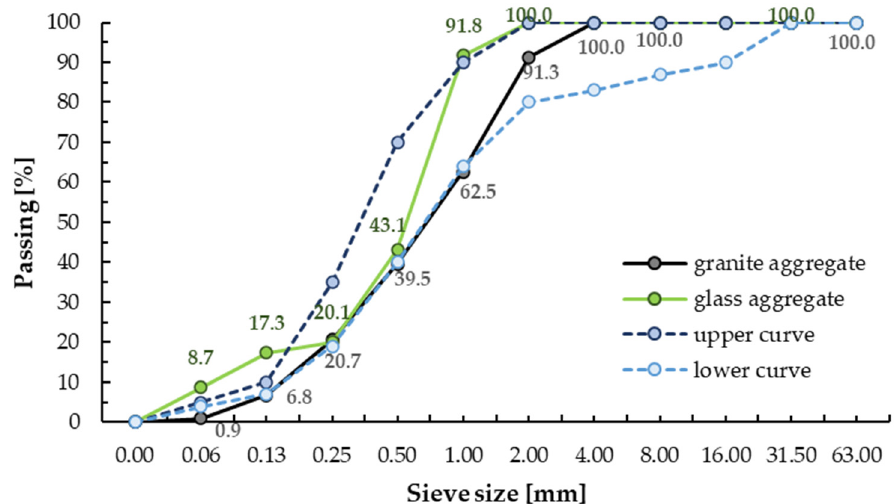
Figure 1. Gradation curve of crushed aggregate.